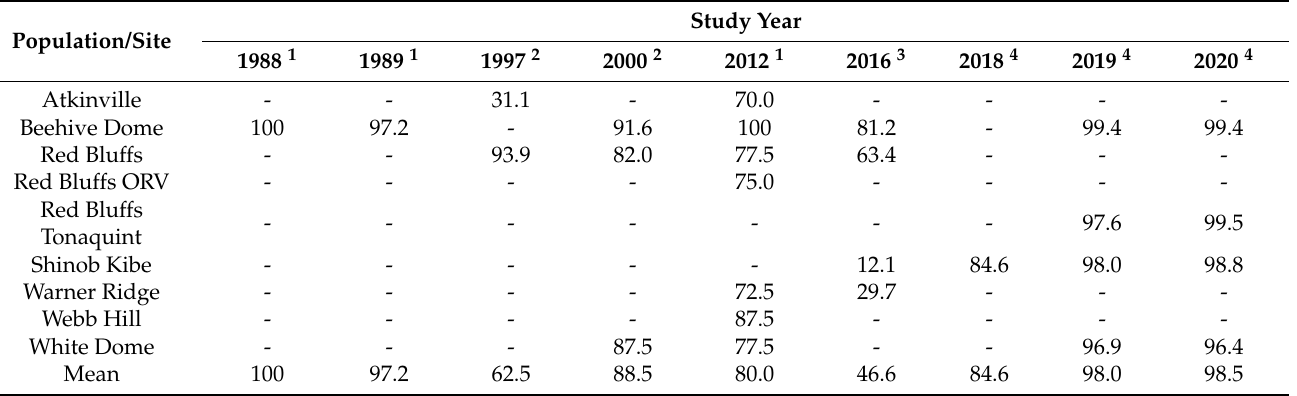
Figure 2. Results of the pollen addition experiment at the Shinob Kibe population in 2018. Treatments are control (open-pollinated with no manipulation), intrapop (pollen added from the Shinob Kibe population), interpop (pollen added from the White Dome population) and White Dome (open-pollinated with no manipulation). Both fertilization success (filled + aborted seed proportion) and filled seed proportion were significantly lower at White Dome than at Shinob Kibe but were not significantly different among manipulation treatments. See Appendix A for full statistical analysis. Table 2. Fruit set percentage data from reproductive output studies of Arctomecon humilis from 1988 through 2021.